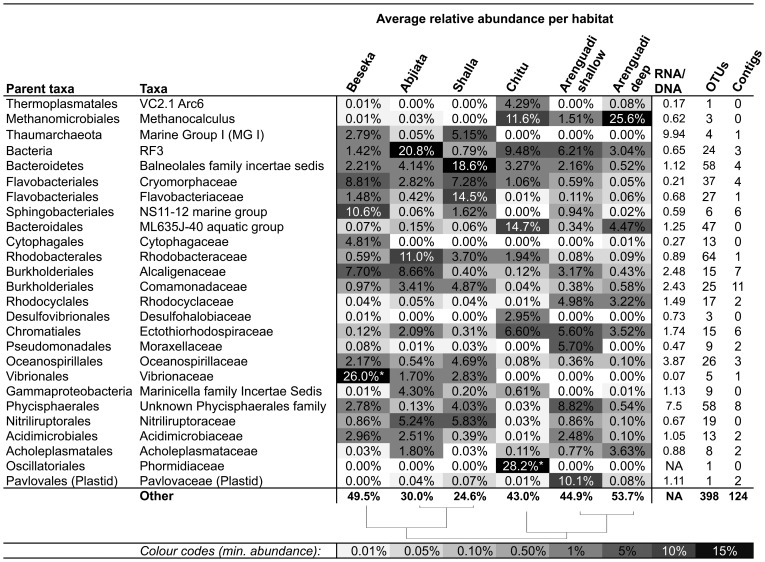
Distribution matrix with, DNA/RNA ratio, number of OTUs and rRNA contigs for the five most abundant taxa in each habitat.Abundances are based on DNA amplicons from collection filters except those indicated with a star (*), instead based on prefilter-derived datasets. Taxa were defined at family level except for RF3 and MG I where information was not available at this resolution. DNA/RNA ratios are based on the dataset with highest RNA abundance and number of rRNA contigs include only those >750 bp. The dendogram indicate average linkage clustering of habitats based on OTU distribution (BC-dissimilarity).